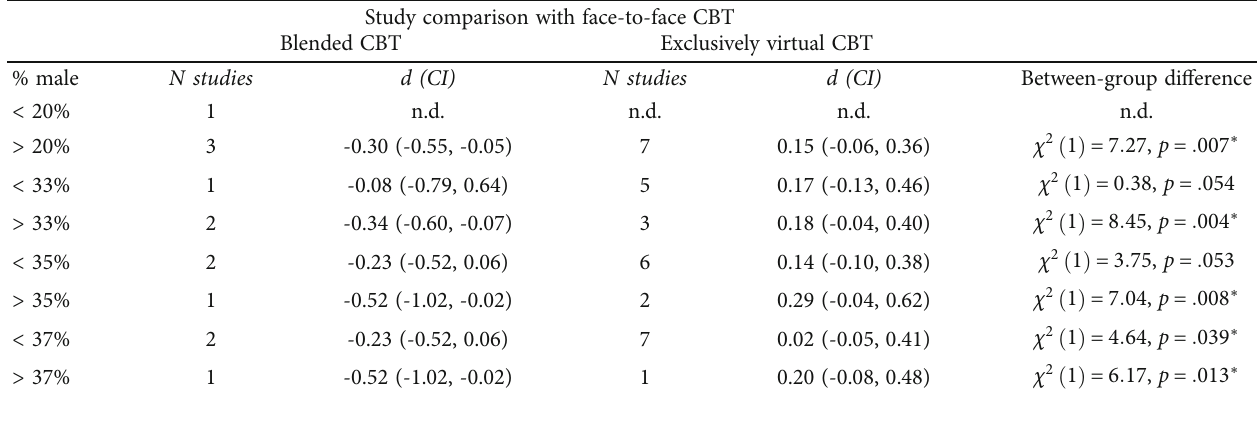
Table 2: Blended versus face-to-face CBT interventions at follow-up